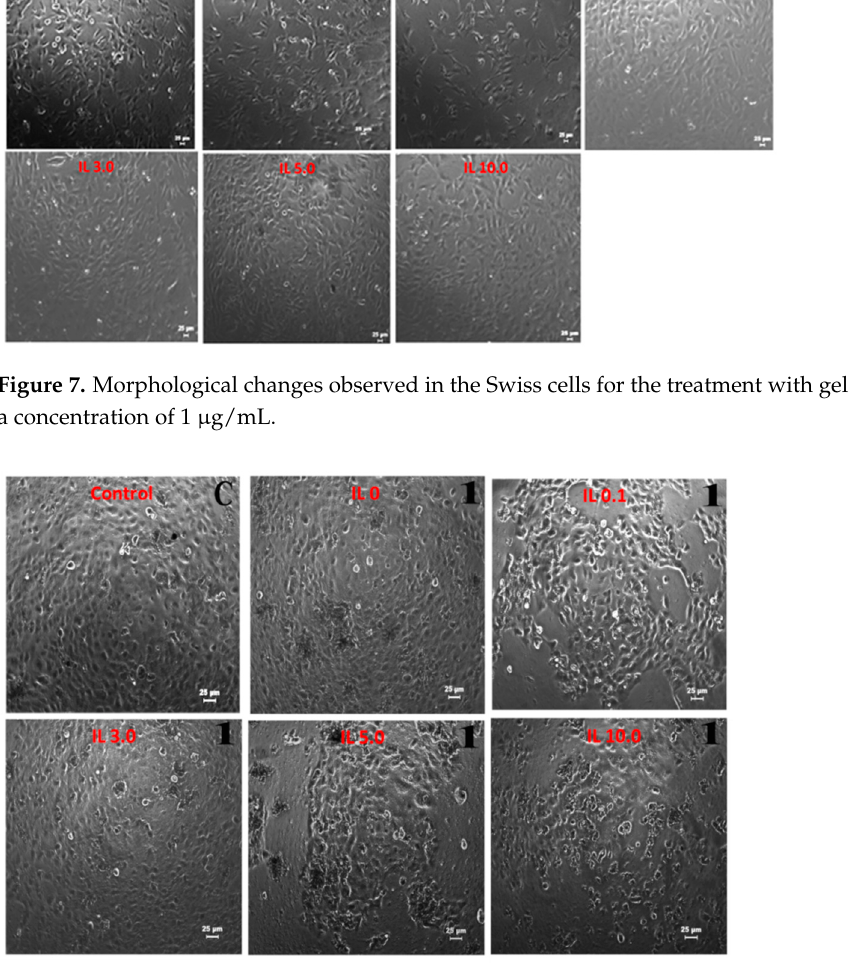
Figure 8. Morphological changes observed in the HaCaT cells for the treatment with gels samples for a concentration of 1 µg/mL.